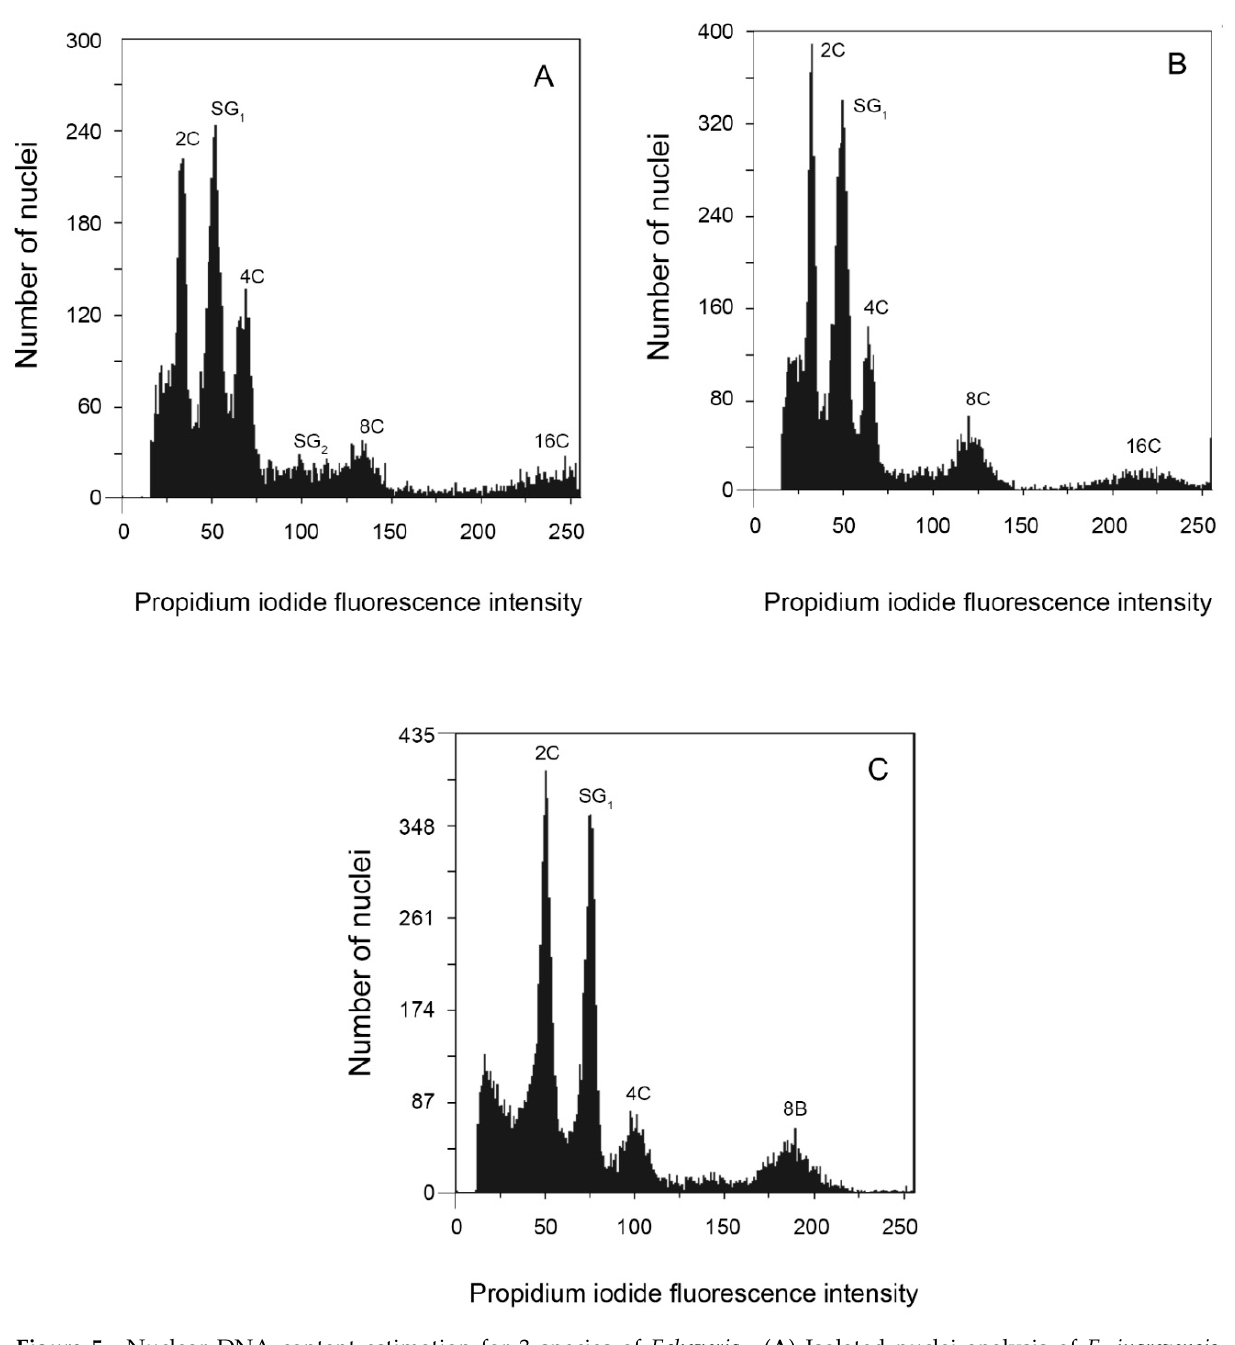
Figure 5. Nuclear DNA content estimation for 3 species of Echeveria. ( A ) Isolated nuclei analysis of E. juarezensis (2 n = 2 x = 54); peaks corresponding to nuclei 2C, 4C, 8C, and 16C from E. juarezensis are shown, peaks SG1 and SG2 represent nuclei from Solanum lycopersicum , used as the Internal standard. ( B ) Isolated nuclei analysis of E. altamirae (2 n = 4 x = 108); peaks corresponding to nuclei 2C, 4C, 8C and 16C from E. altamirae are shown; peak SG1 represents nuclei from Zea mays , used as the internal standard. ( C ) Isolated nuclei analysis of E. novogaliciana (2 n = 6 x = 176); corresponding to nuclei 2C, 4C, and 8C from E. novogaliciana are shown; peak SG1 represents nuclei from Pisum sativum used as the internal standard.